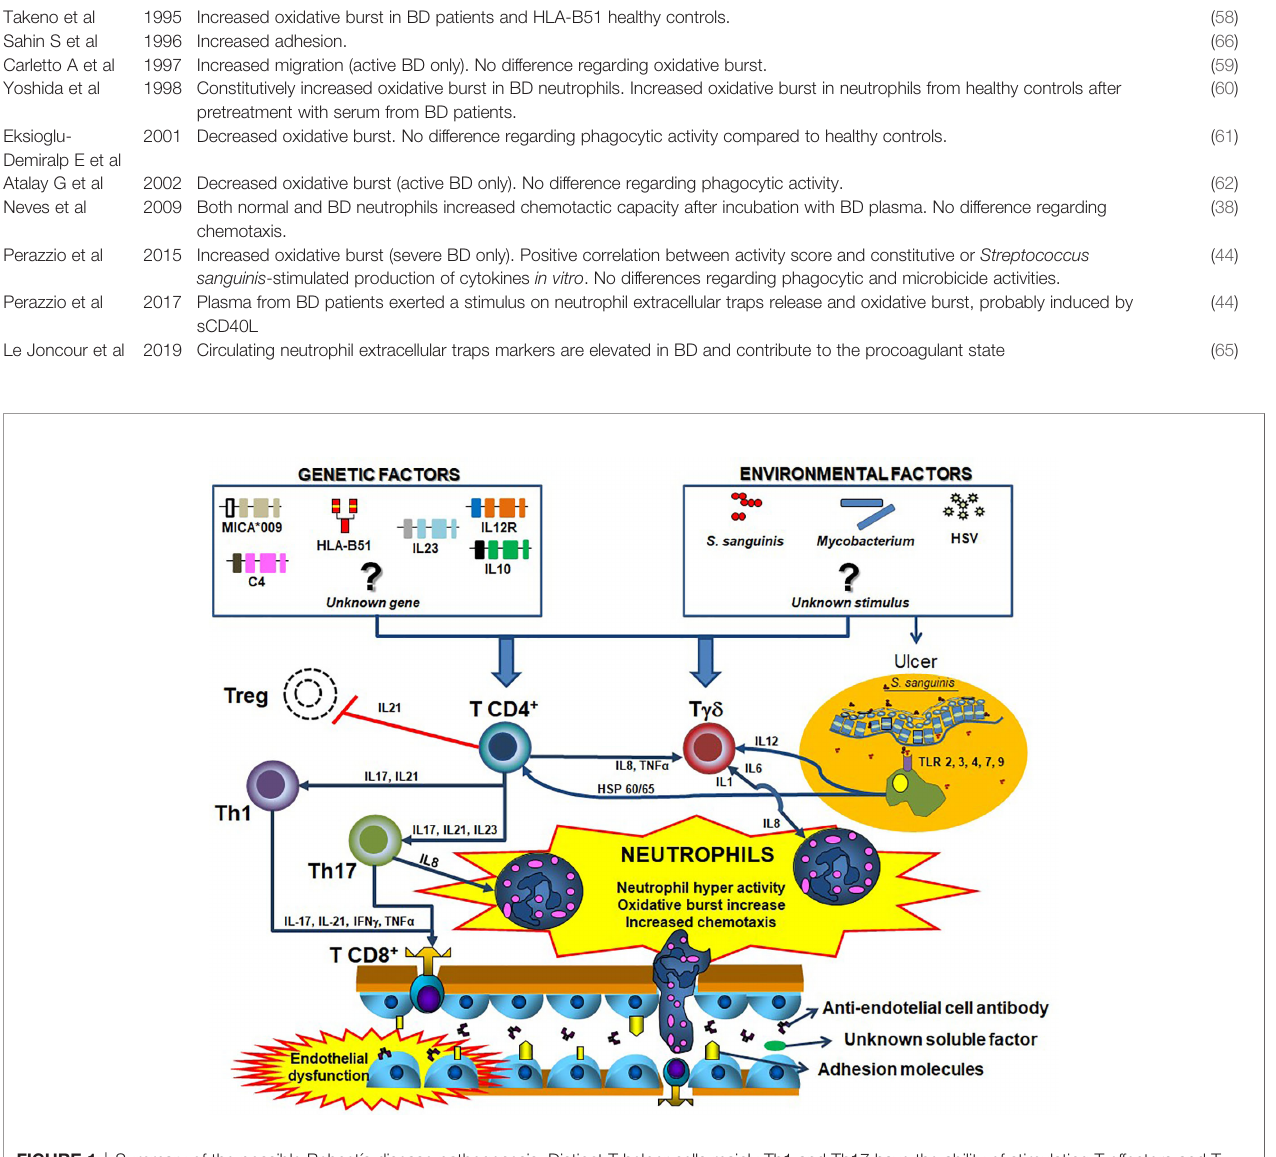
FIGURE 1 | Summary of the possible Behçet´s disease pathogenesis. Distinct T helper cells mainly Th1 and Th17 have the ability of stimulating T effectors and T regulatory cells especially by the action of cytokines. Although some remain unknown, several genetic (e.g.: HLA-B*51 , MICA, C4 copy number variation, among others),,, and environmental factors (e.g., Streptococcus sanguinis , Herpes-simplex virus , mycobacteria, among others) are involved in the process, by facilitating the activation of T cells. Similarly, the antigen presenting cells, especially macrophages from mucosa, stimulate immune cells by Toll-like receptors activation. All these innate and adaptive immune pathways culminate with the sequential neutrophil activation, considered the most important element in BD pathogenesis. blue closed arrows represent stimulation of a cell subtype mediated by cytokines, while red open lists represent